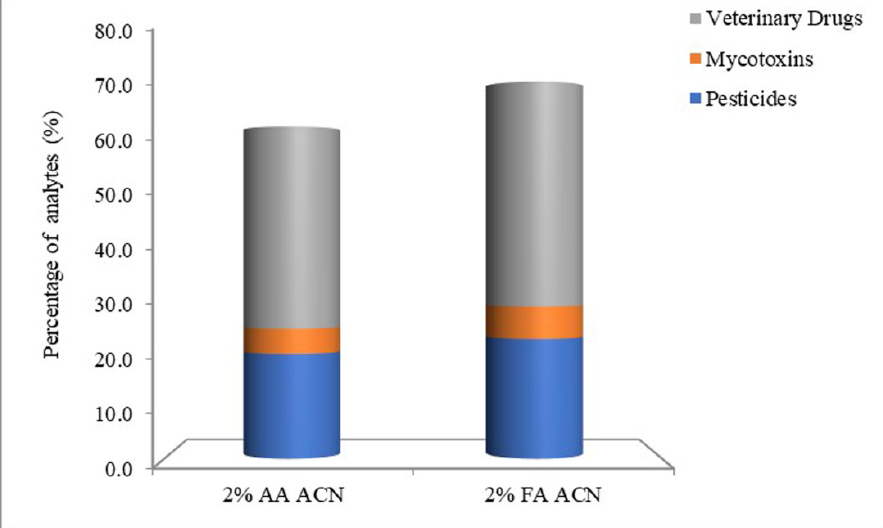
Figure 2. Comparison of ME values between 0.8 and 1.2 by extraction of 2% AA ACN and 2% FA